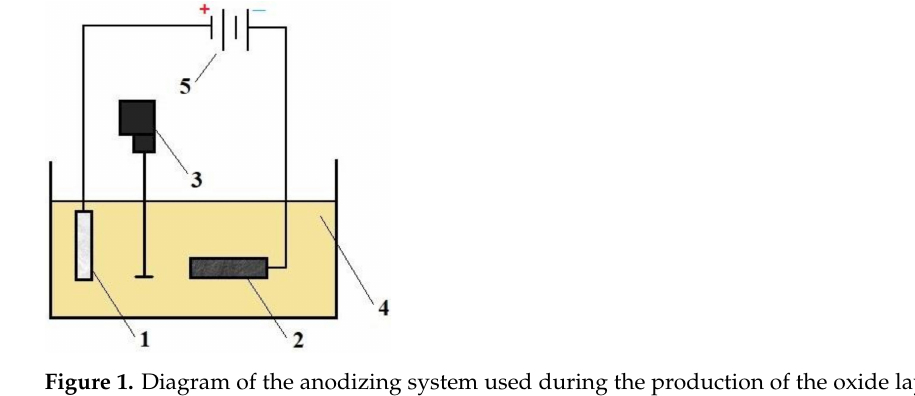
Figure 1. Diagram of the anodizing system used during the production of the oxide layer: ( 1 ) alu- minum alloy EN AW-5251 (anode); ( 2 ) lead plate (cathode); ( 3 ) mechanical stirrer; ( 4 ) electrolyte; ( 5 ) power supply.